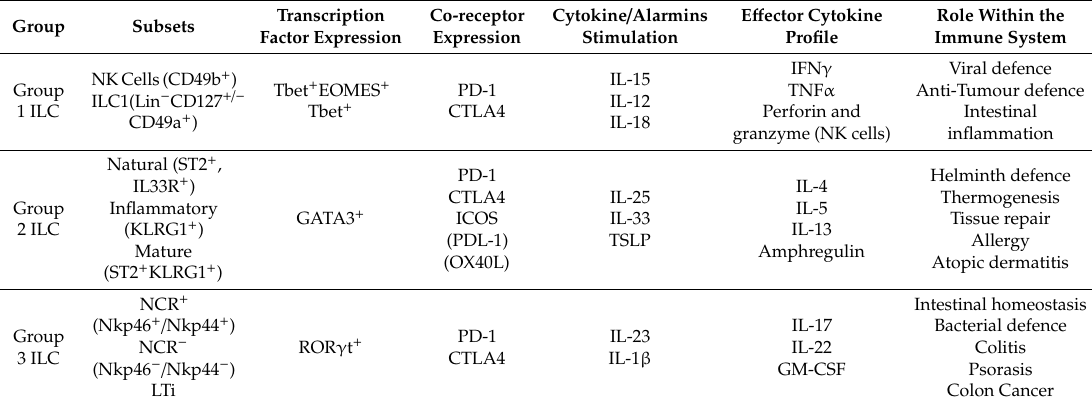
Table 1. Summary of Innate Lymphoid Cell subsets and